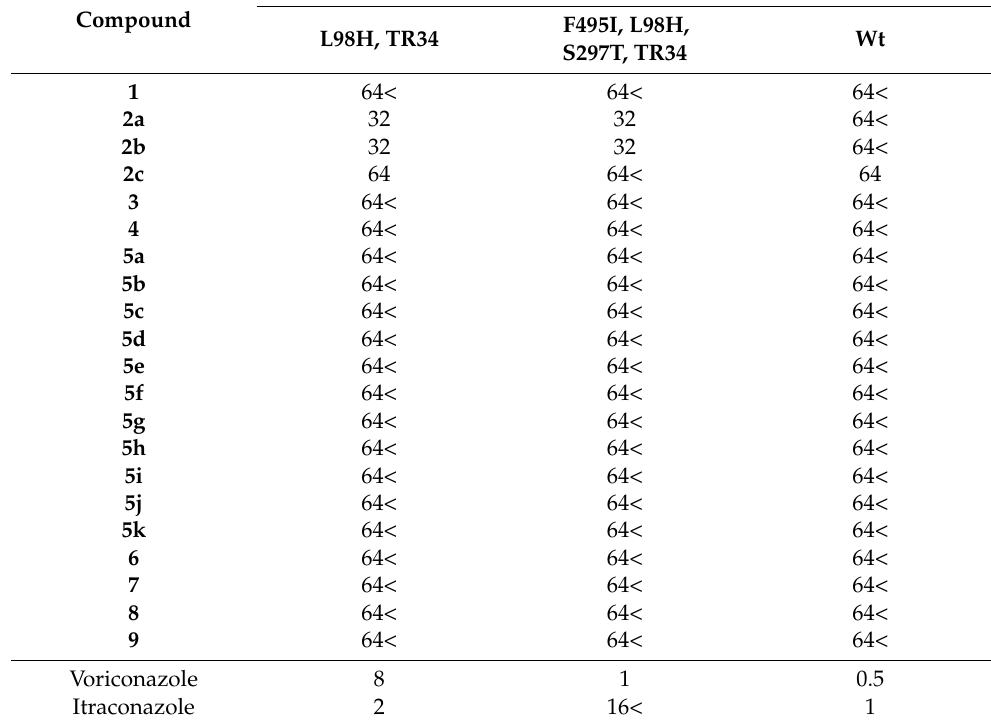
Table 4. The antifungal activity expressed as minimal inhibitory concentration (MIC, µ g/mL) of compounds 1 – 9 and comparator drugs (voriconazole, itraconazole) against azole-resistant Aspergillus fumigatus with genetically defined resistance